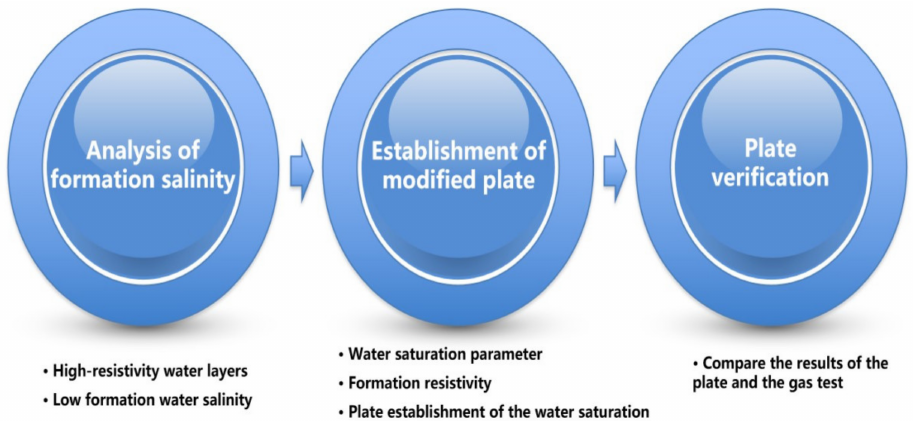
Figure 1. Technology workflow of fluid identification of Chang 8 Member in Ordos